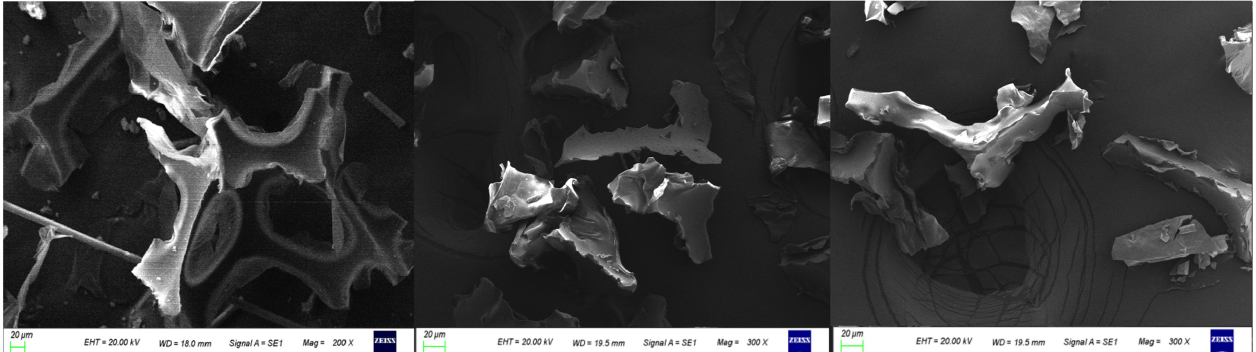
Figure 8. Microstructure of polyurethane powders with different mesh numbers: ( a ) 40 mesh, ( b ) 120 mesh, ( c ) 200 mesh.